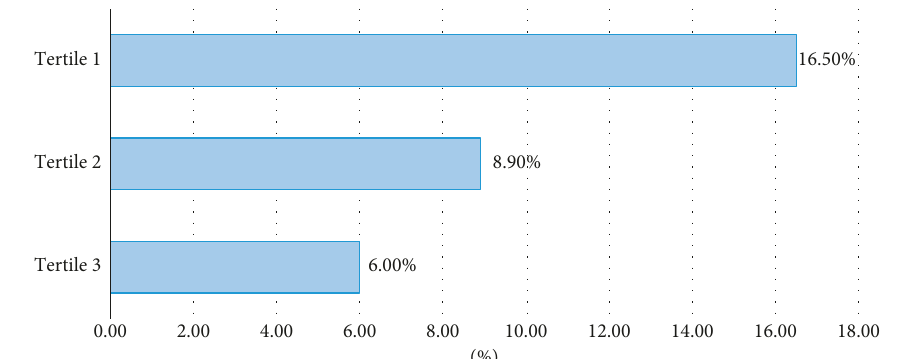
Prostate radiotherapy vs. Prostate cancer Prostate chemotherapy vs. Prostate cancer Prostate cancer hormone therapy vs. Prostate cancer